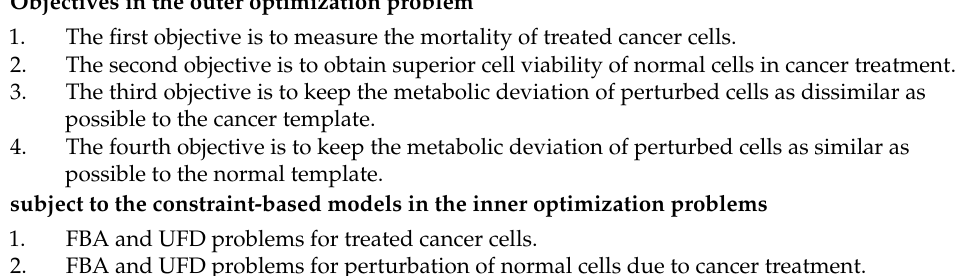
Table 1. Optimization framework for IACT by evaluating the performance of identified targets according to four